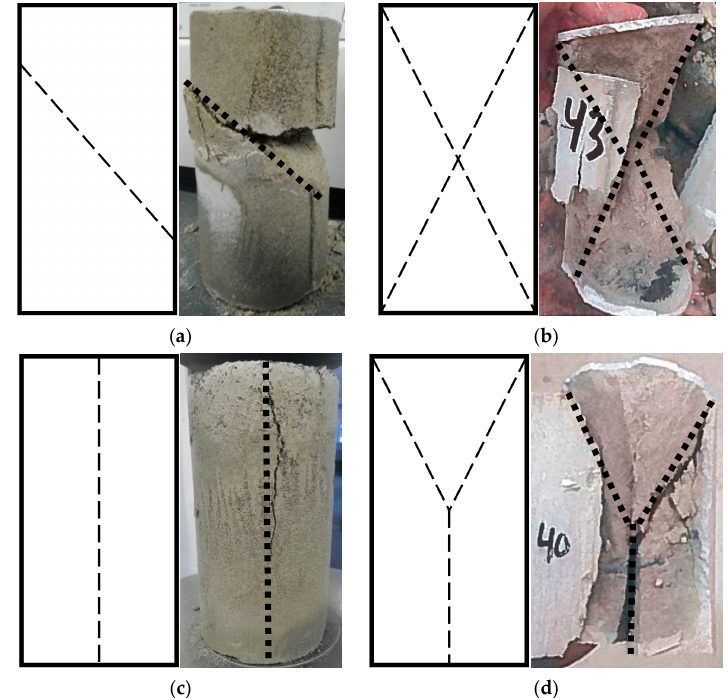
Figure 1. Typical failure modes of cylindrical cemented backfill samples submitted to uniaxial compression test conditions: ( a ) diagonal shear; ( b ) ‘X’ cone-shear; ( c ) single (or columnar) split; ( d ) ‘Y’ cone-split (combination of shear and split).